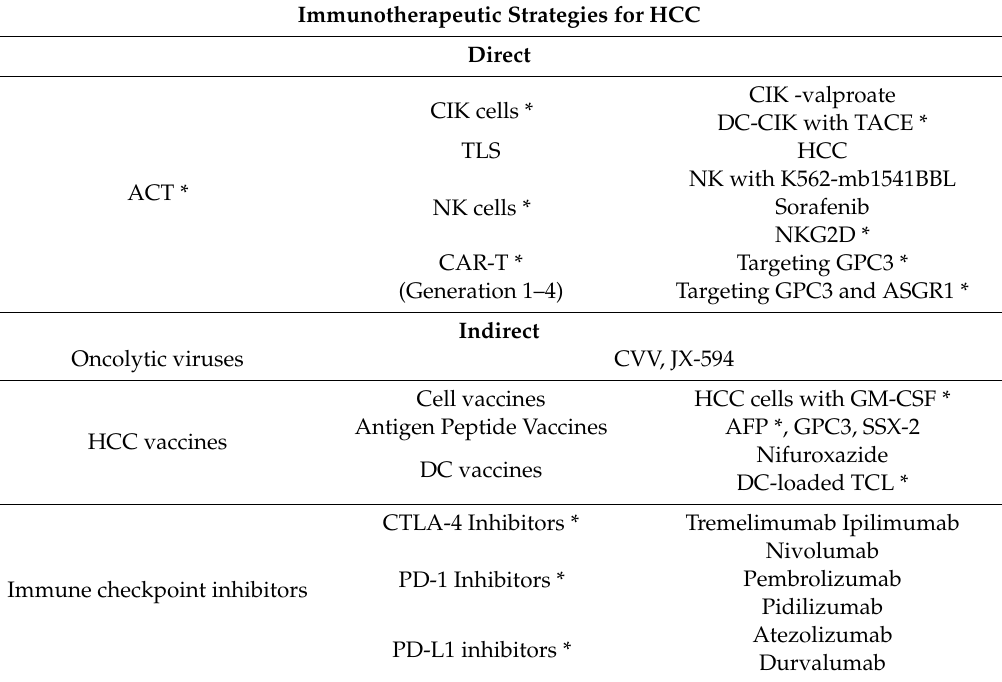
Table 1. Main immunotherapeutic strategies for hepatocellular carcinoma (HCC). Immunotherapeutic Strategies for